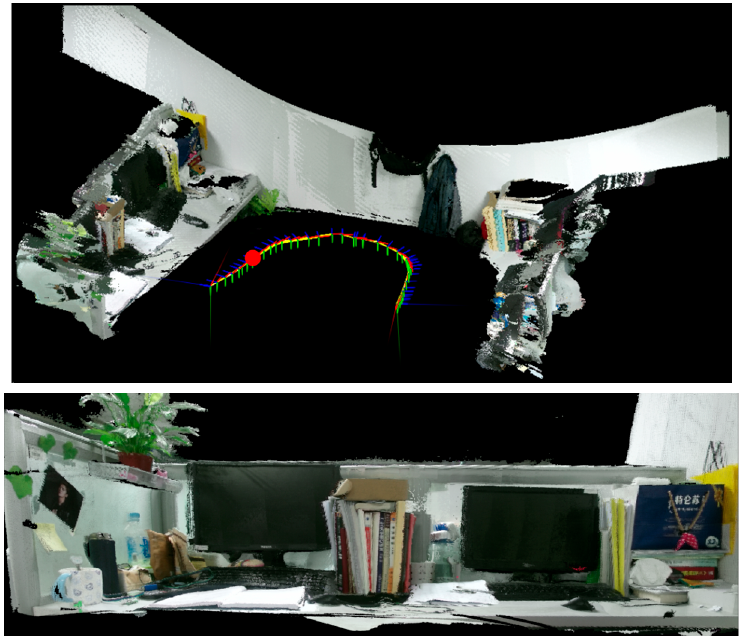
Figure 10. Point cloud of this indoor scene: overall view ( top ); a side view at the red point position in the overall view ( bottom ).